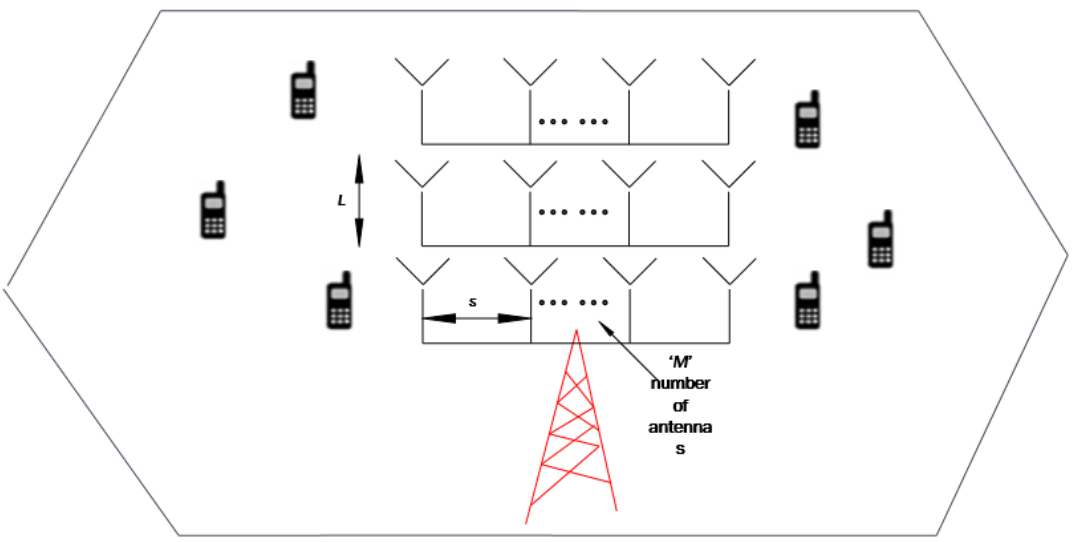
Figure 2. Massive MIMO with M antenna terminals.